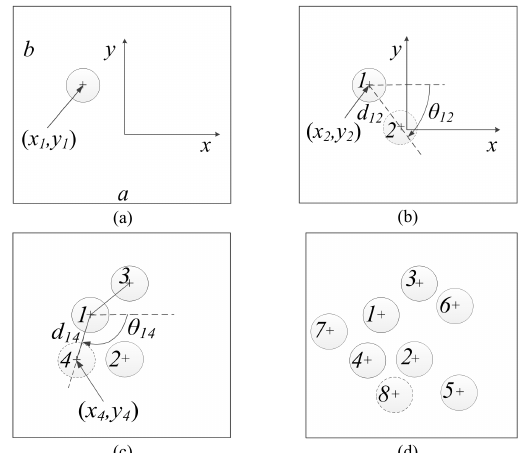
Figure 2. Schematic illustration of the modified nearest neighbor algorithm (NNA) algorithm. ( a ) Step 1: generation of the first fiber (fiber #1) in the central area of the window; ( b ) step 2–4: generation of the fiber #2 with inter-fiber distance d 12 and the orientation angle θ 12 satisfying the statistical distribution; ( c ) step 5–6: generation of more fibers around fiber #1; ( d ) step 7–8: repeating of the previous steps followed by switching the reference fiber.